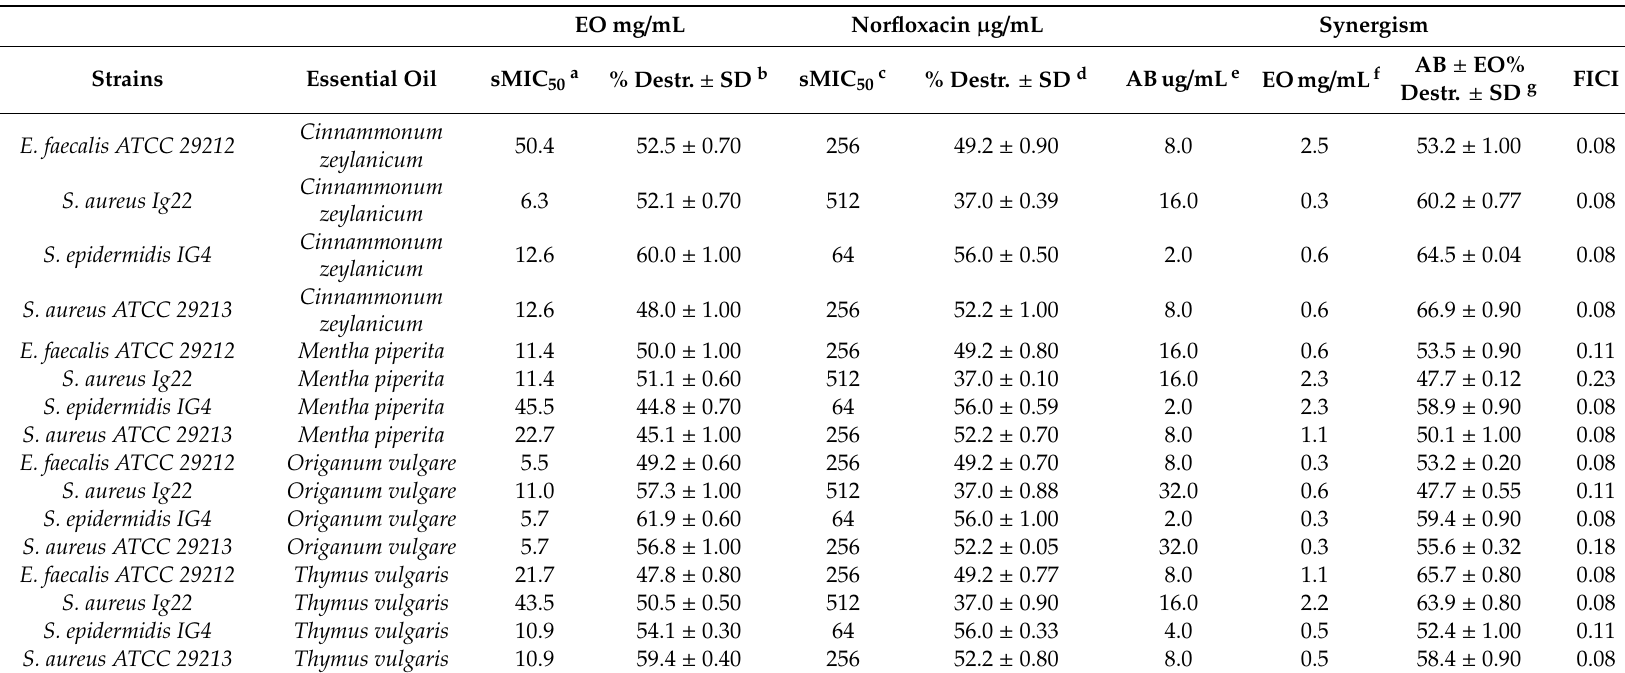
Table 4. Desctruction e ff ect of di ff erent EOs alone and in combination with norfloxacin on mature